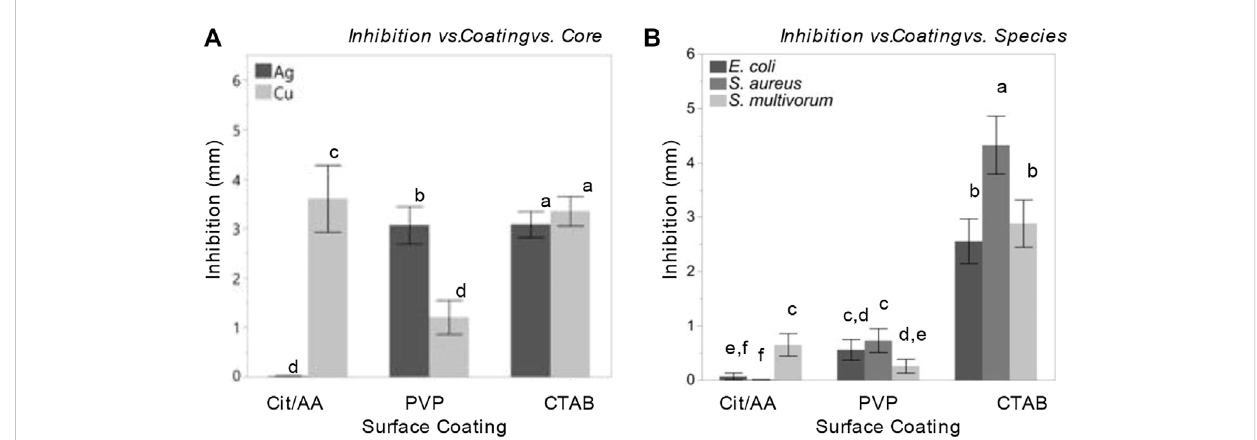
Nanoparticles and their surface coatings produce distinct antibacterial effects but have consistent impact across diverse bacterial species. Comparison of least squares means and 95% con fi dence intervals for bacterial inhibition following nanoparticle treatment resulting from a